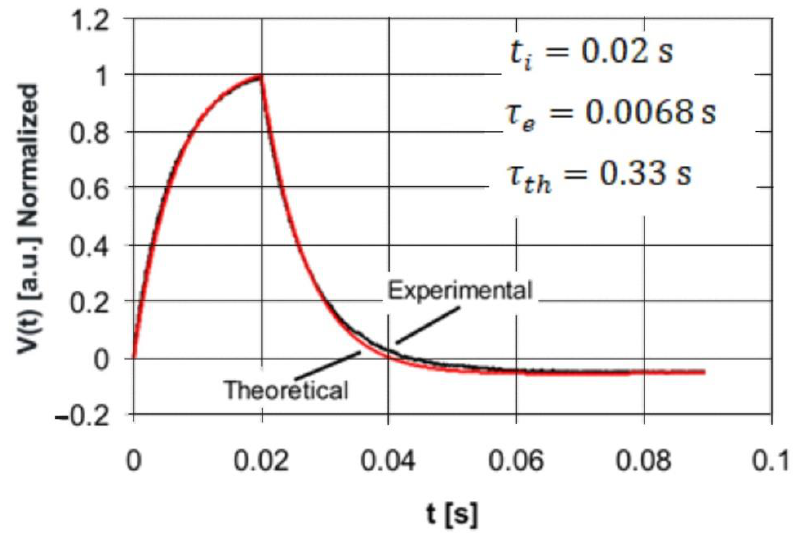
Figure 7. Comparison of the normalized experimental and theoretical voltage responses of the PE10-S-Q detector to the rectangular radiation pulse of duration t i = 0.02 s.